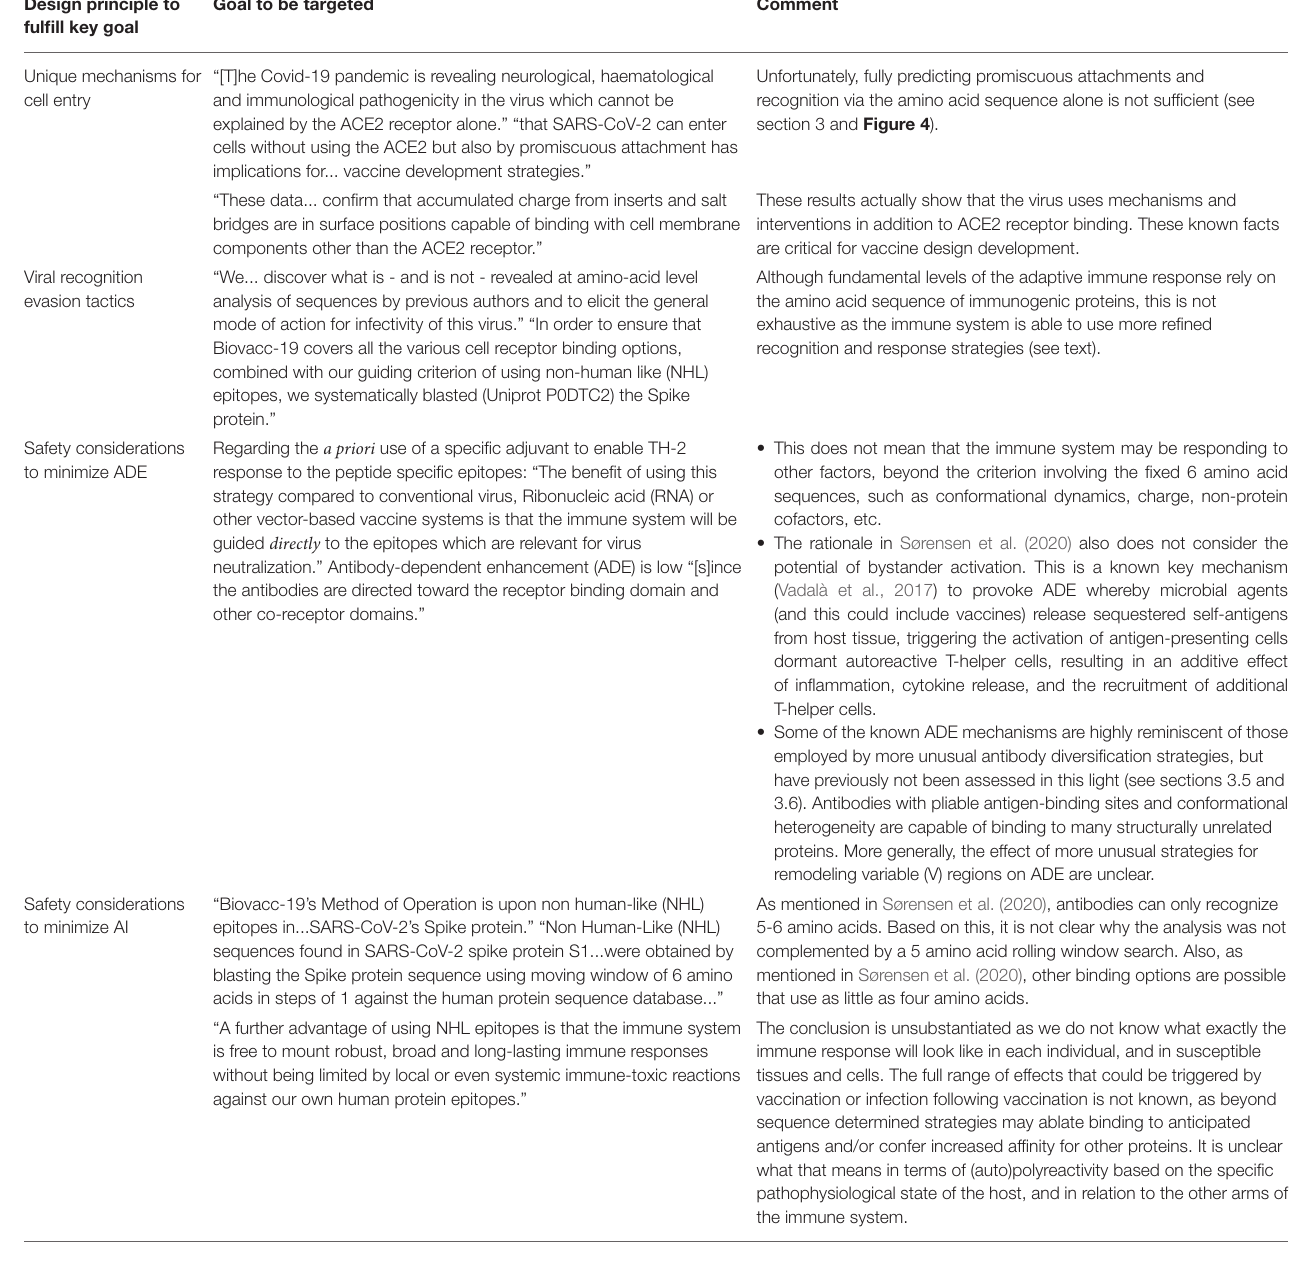
TABLE 2 | Analysis of the claims made in Sørensen et al. (2020), regarding safety and efficacy of Biovacc-19. Design principle to fulfill key